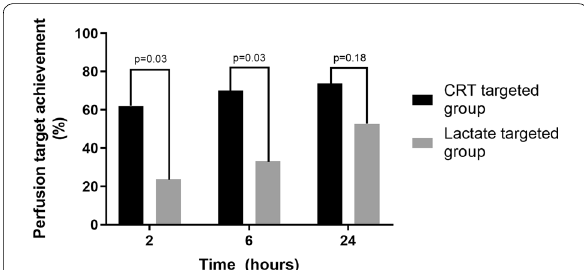
Fig. 2 Achievement of perfusion target according to study arm at 2, 6 and 24 h. CRT: Capillary refill time